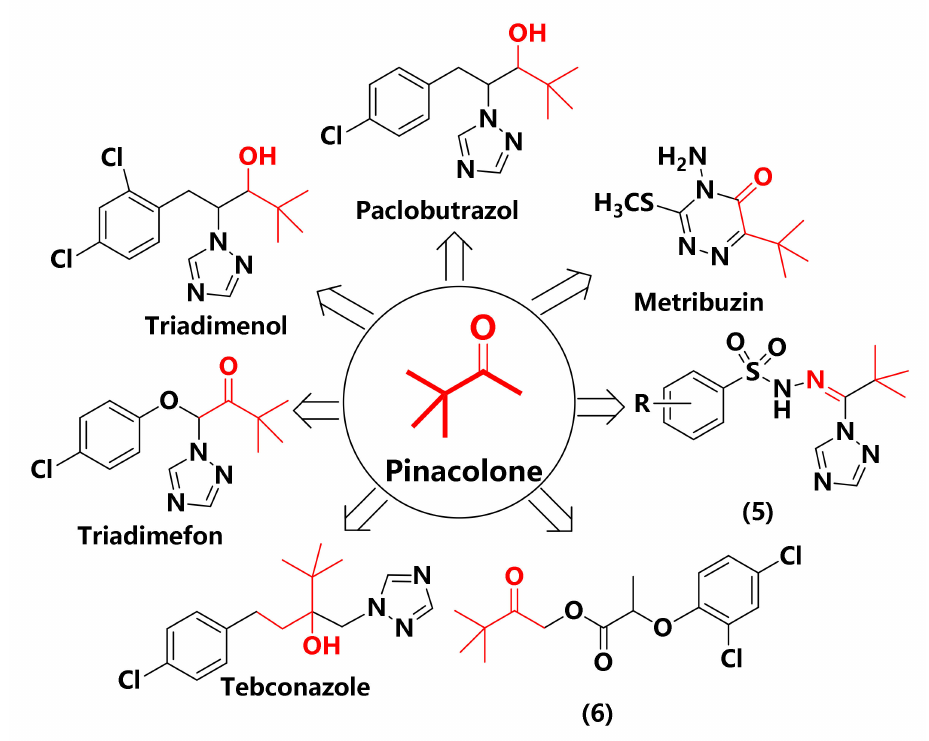
Figure 2. Agricultural active compounds containing pinacolone